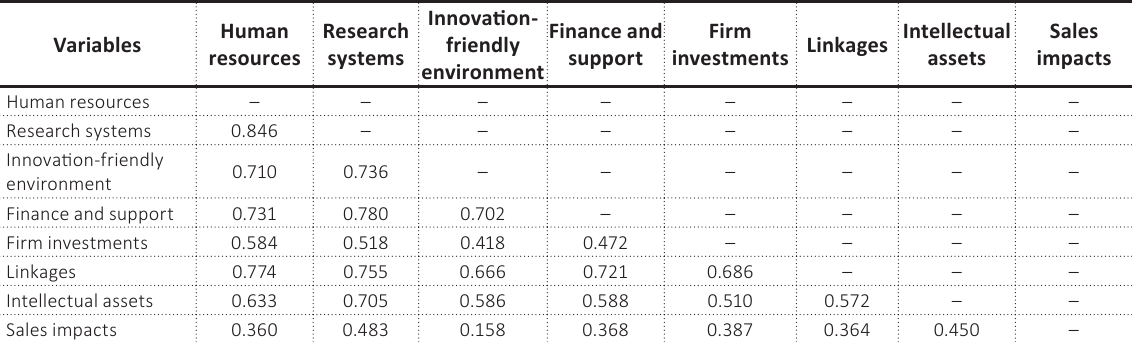
Table 1. Correlation matrix